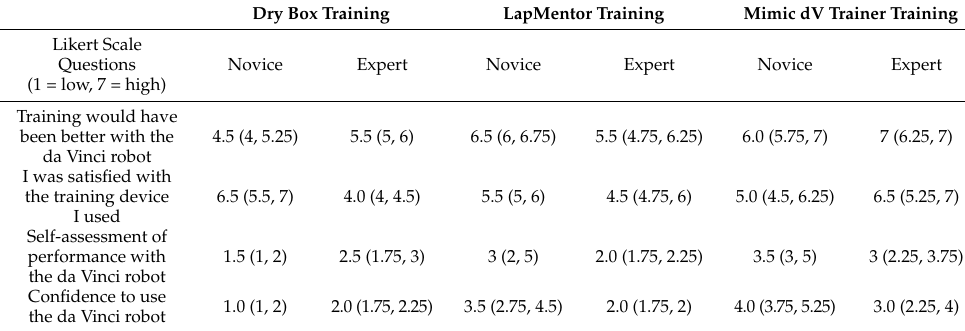
Table 5. Survey after assessment session (Self-assessment